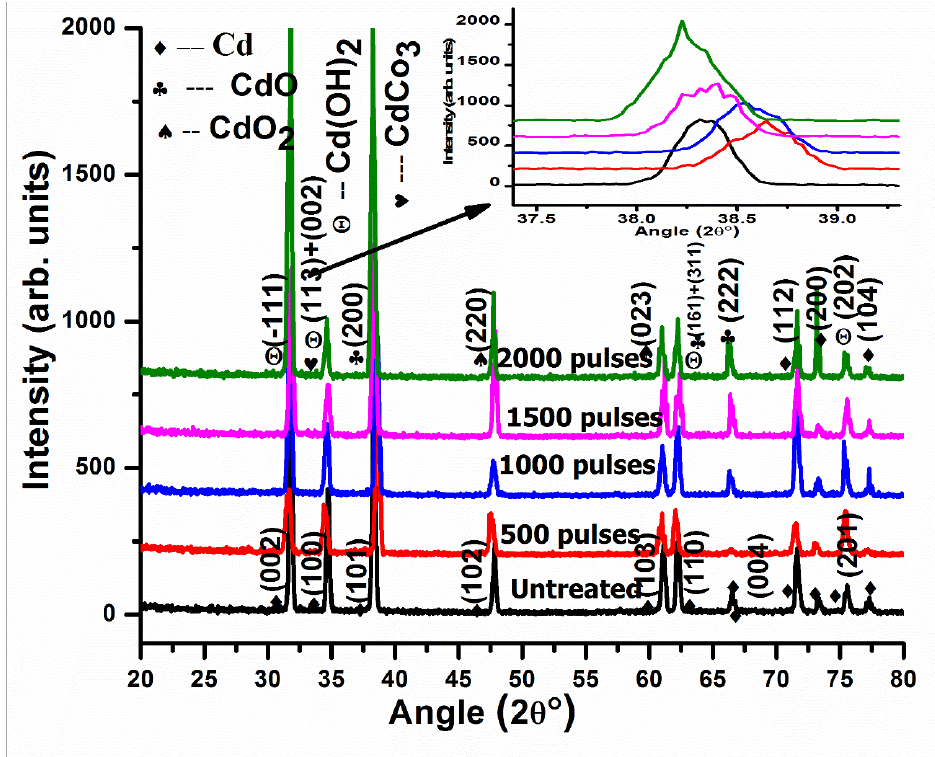
Figure 6. XRD patterns of pristine and laser ablated Cd exposed to 500, 1000, 1500, and 2000 laser pulses at a constant fluence value of 3.6 Jcm − 2 in ethanol, enlarged view of peak (200) shown as inset at top right corner.